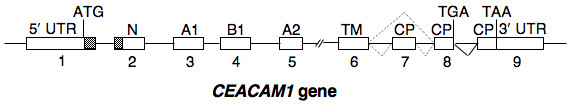
Schematic representation of human CEACAM1 gene and its alternative splicing into long and short cytoplasmic domain isoforms. Open boxes or lines represent exons and introns, respectively. Shaded portions of exons denote the leader sequence. The broken lines represent inclusion or exclusion of exon 7 thereby generating CEACAM1-L or CEACAM1-S splice variants, respectively. Numbering of the exons is indicated below each exon. N, A1, B1 and A2 refer to the Ig domains [54]. UTR, untranslated region; ATG, the start codon; TM, transmembrane domain; CP, cytoplasmic domain; TGA and TAA, the stop codons for short and long cytoplasmic domain isoform, respectively.